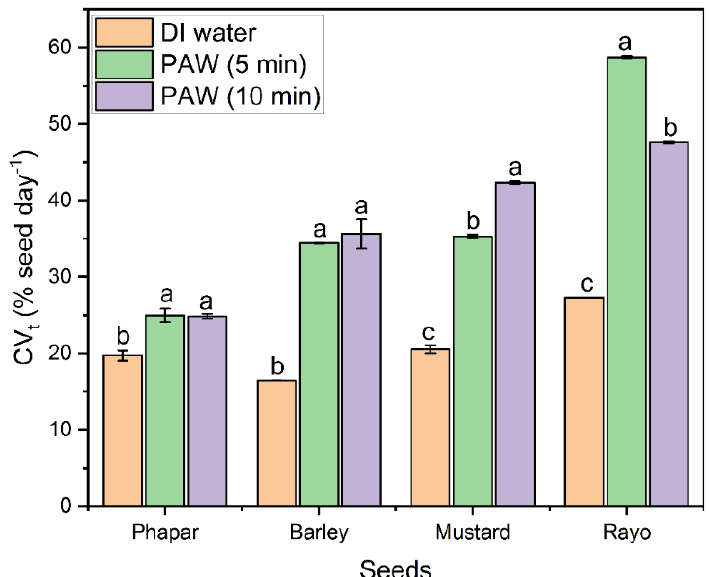
Figure 7. Impact of PAW on the coefficient of variation of germination time (CV t ) of seeds. Different letters (a–c) indicate significant differences at p < 0.05 level among all treatments as determined by Tukey’s multiple comparison test.